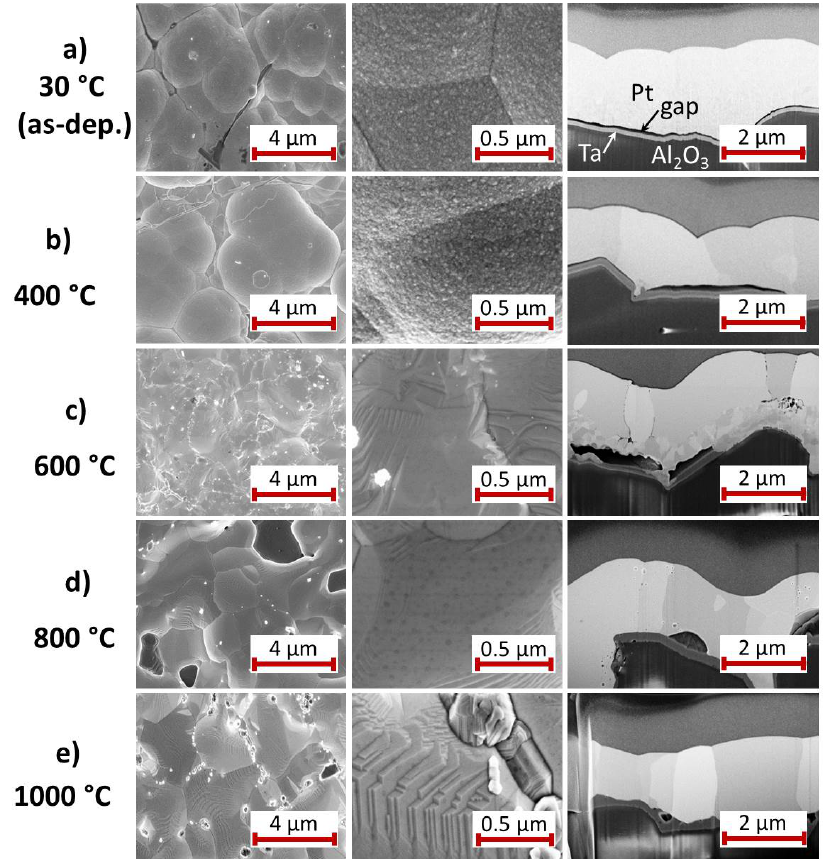
Figure 7. SEM images (InLens, 5 kV, 3 mm working distance) with two different magnifications of the surface of the electrodeposited Pt ∗ film on Ta seed layer ( a ) after deposition and after annealing for 2 h in air at ( b ) 400; ( c ) 600; ( d ) 800 and ( e ) 1000 ◦ C. On the right hand side a SEM image (InLens, 3 kV, 5 mm working distance) of the film cross-section is presented.